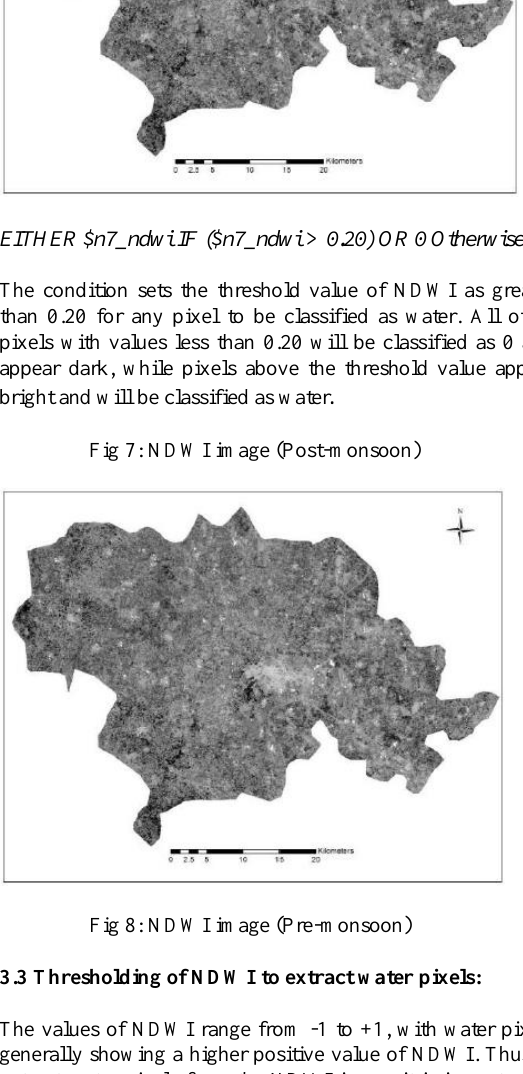
Fig 8: NDWI image